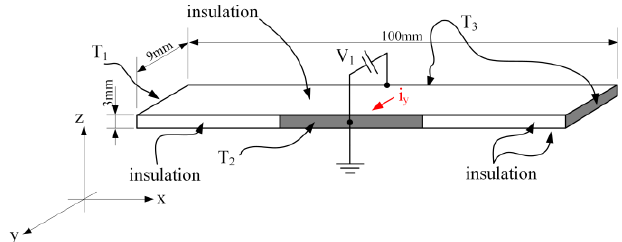
Figure 8. An example of the problem of heat conduction in a solid with partial thermal insulation, initial and boundary conditions, and internal heat generation.